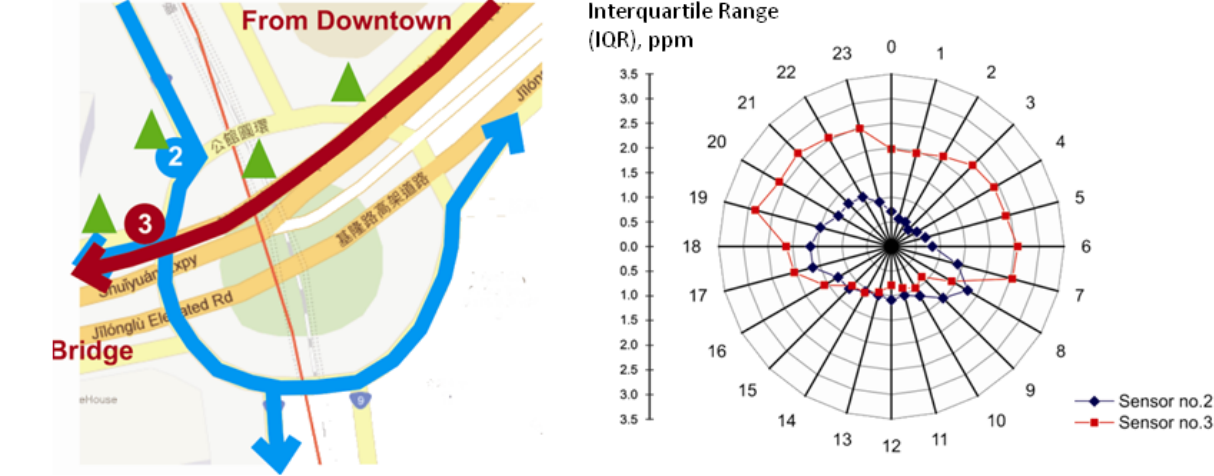
Figure 8. The hourly interquartile range (IQR) of CO concentrations of the sensor No. 2 and No. 3 at 24 hours a day from July to September 2010 (right panel). Sensor No. 3 represents a location affected by the difference of traffic flows on weekdays and weekends, but sensor No. 2 reflects a location that always accumulates high traffic volume from downtown to the residential areas (left panel). The traffic flows from downtown (blue lines) converge on the arterial and are diverted to different roads. The difference between weekdays and weekends only has a slight effect on sensor No. 2. The greater IQR of sensor No. 3 could be explained by the traffic flow (red line) only appearing during